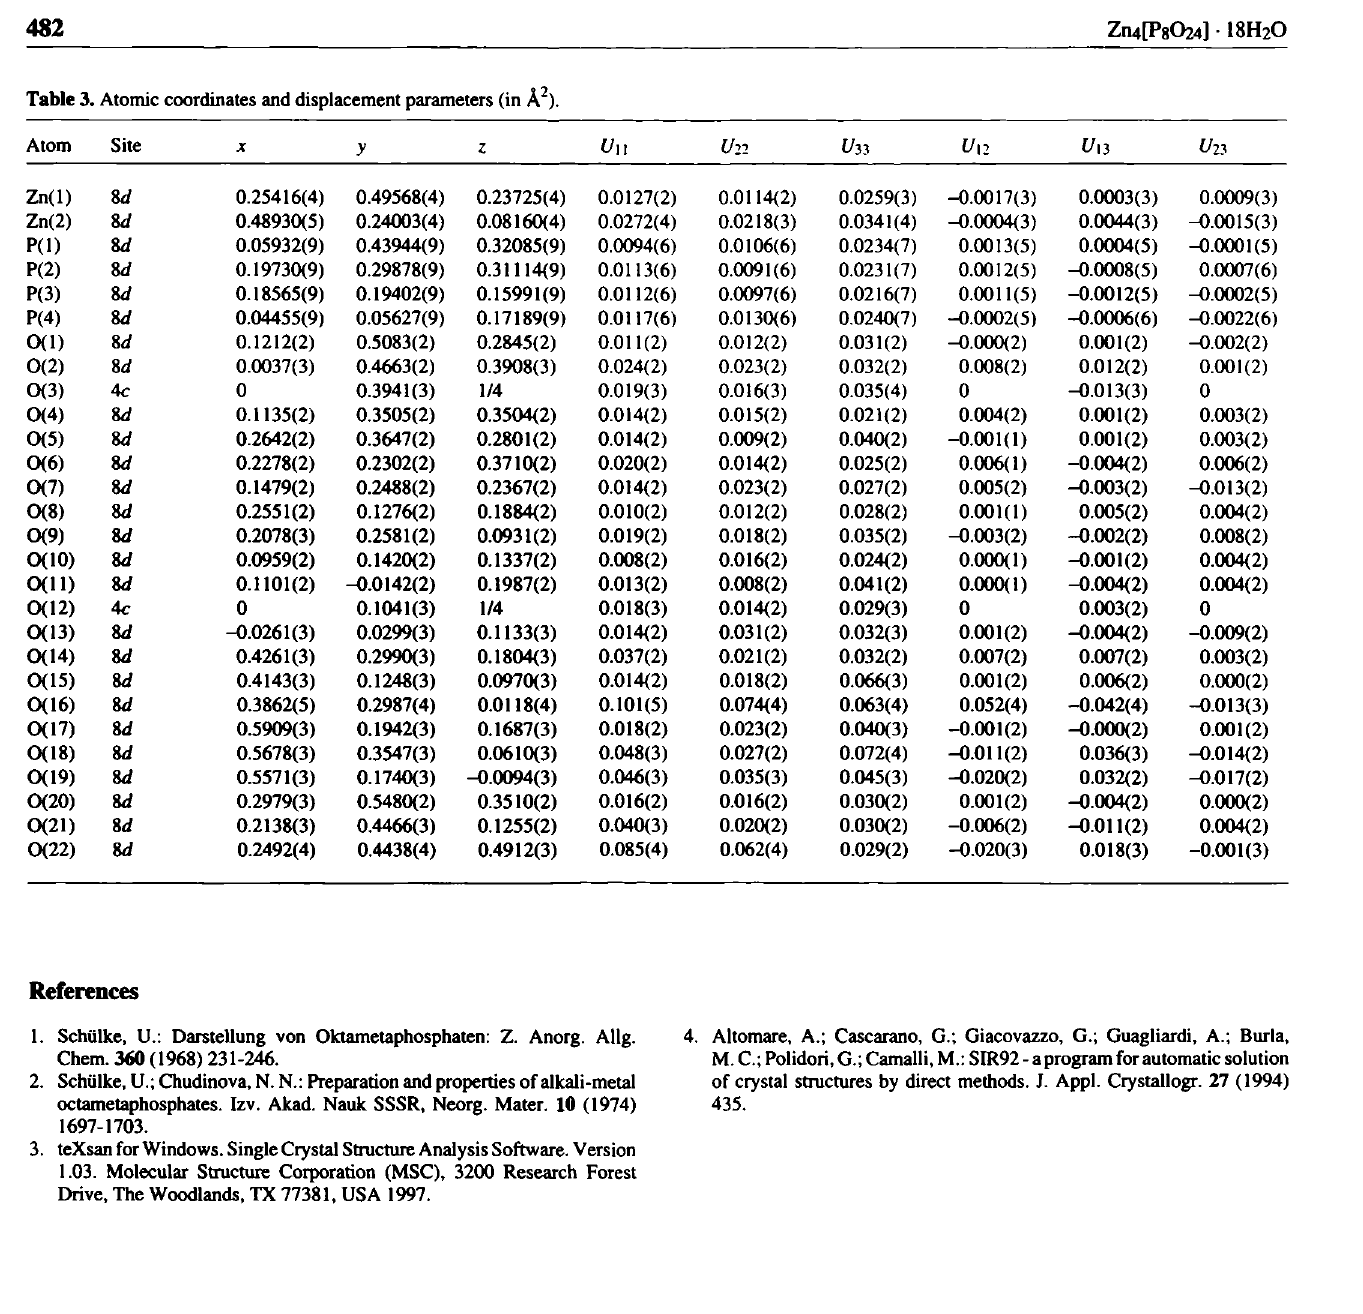
Table 3. Atomic coordinates and displacement parameters (in k 2